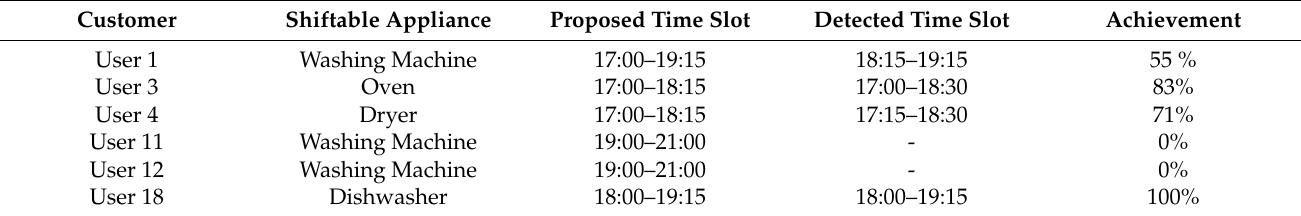
Table 3. Optimal DR application result. Experiment day: 9 June